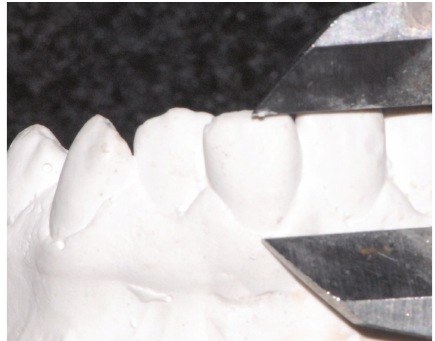
Figure 2: Before the orthodontic treatment, crown height was assessed with a digital caliper by measuring the distance between the most coronal point of incisor margin and the most apical point of gingival margin.